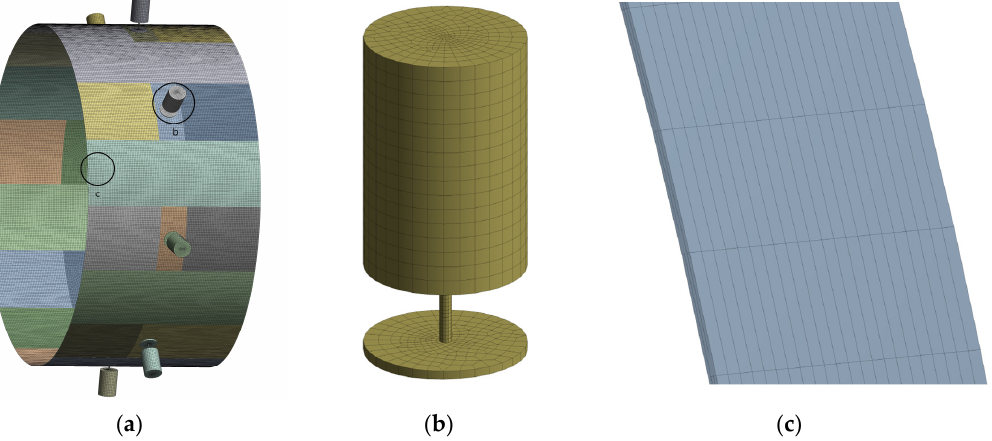
Figure 4. ( a ) Gas film flow filed meshing (1/2 model); ( b ) orifice meshing densification; ( c ) meshing layering.